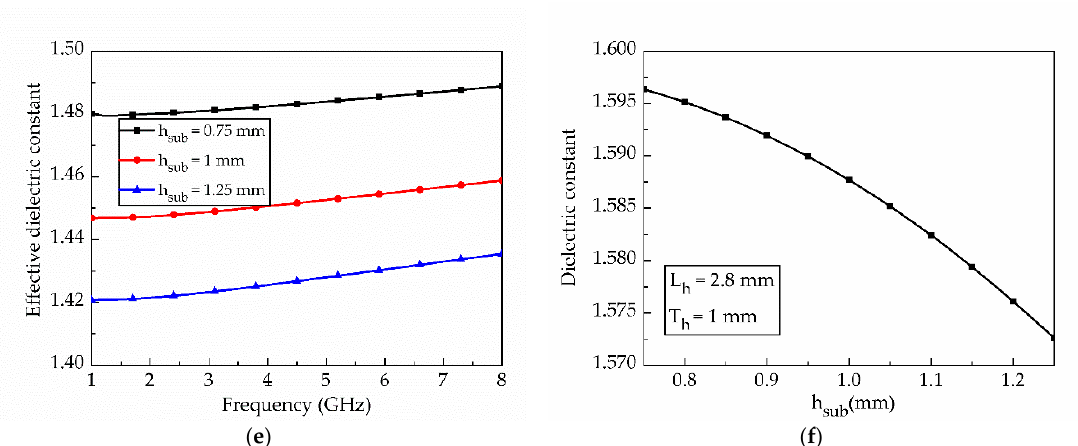
Figure 3. Simulated results of honeycomb substrate with microstrip line: ( a ) effective dielectric constant with respect to L h ; ( b ) dielectric constant with respect to L h ; ( c ) effective dielectric constant with respect to T h ; ( d ) dielectric constant with respect to T h ; ( e ) effective dielectric constant with respect to h sub ; ( f ) dielectric constant with respect to h sub .